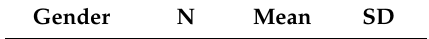
Table 2. Access to credit among male and female youth.